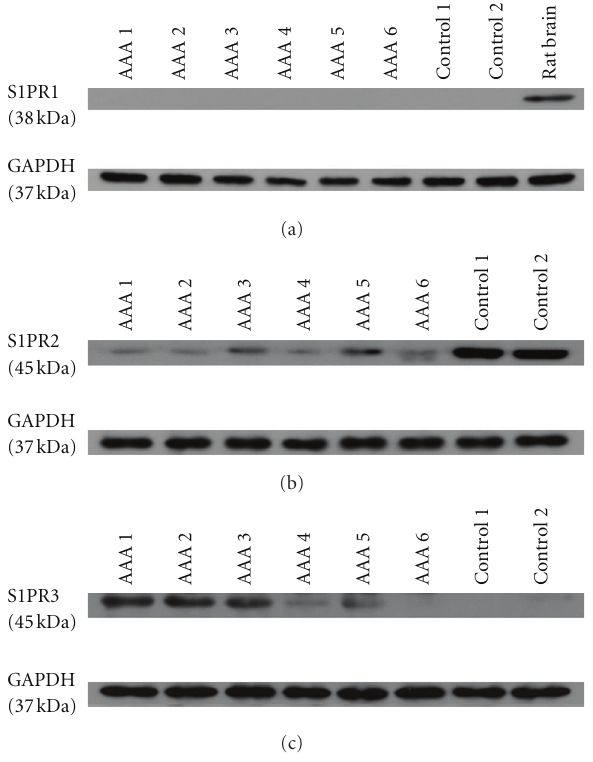
Figure 1: Representative pictures of western blot analysis of S1P receptors in AAA and control aortic tissues. S1P1 expression was undetectable in both AAA and normal aortas, while it became detectable in rat brain tissues (a). Expression level of S1P2 protein was significantly decreased in AAAs compared with control aortas (b). S1P3 expression was detectable in AAAs only (c). GAPDH antibody was used as internal positive control in each WB experiment. Figure 2: Quantitative analysis of S1P2 (upper panel) and 3